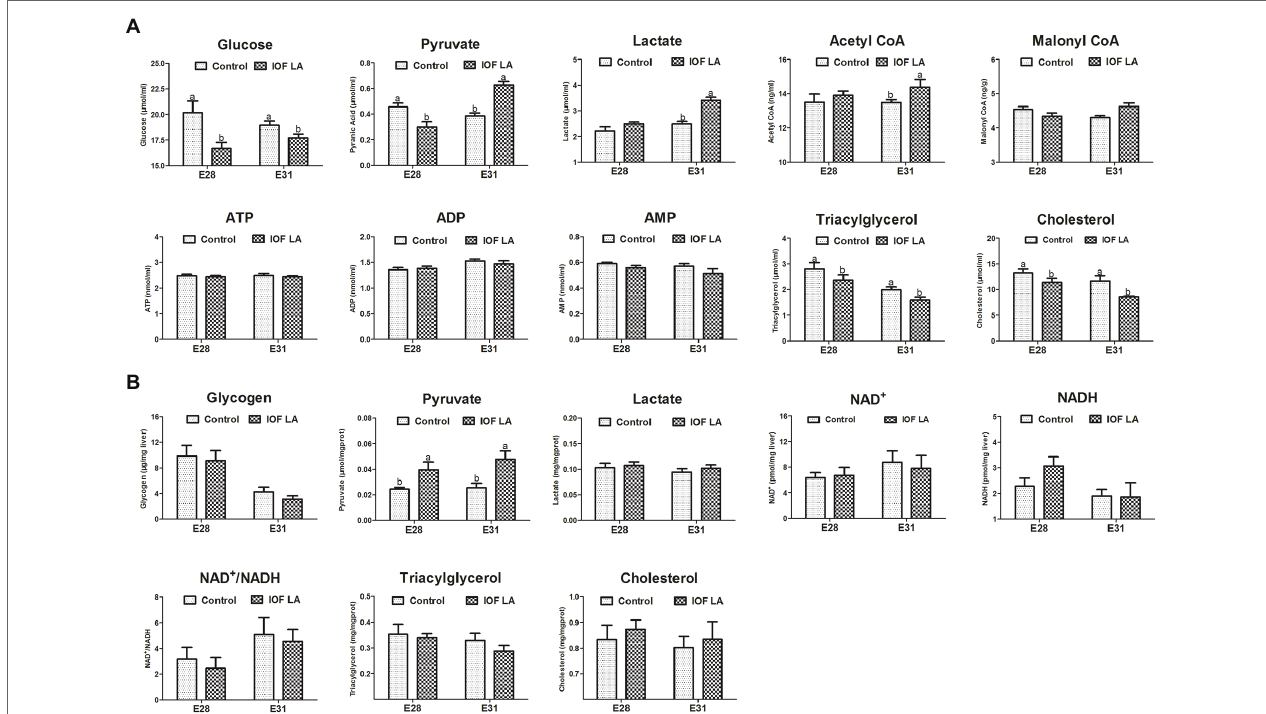
FIGURE 3 | Effect of in ovo feeding linoleic acid on the changes of biochemical index in the avian model. (A) serum biochemical index; (B) hepatic biochemical index. Control group was in ovo injected with PBS, and IOF LA was the treatment group in ovo feeding linoleic acid on E25. Abbreviations: CoA, coenzyme A; ATP, adenosine triphosphate; ADP, adenosine diphosphate; AMP, adenosine monophosphate; NAD, nicotinamide adenine dinucleotide; NAD + , the oxidated form of NAD; NADH, the reduced form of NAD. Data are expressed as mean ± SEM ( n = 6), and bars on the same sampled day with different lowercase letters indicated statistically significant differences ( t -test, p < 0.05).